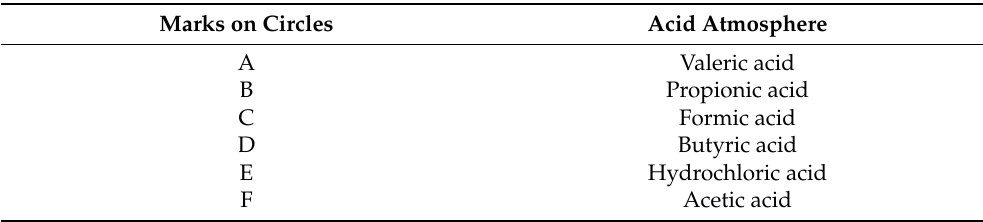
Table 4. Descriptions of the letters on the tested Petri